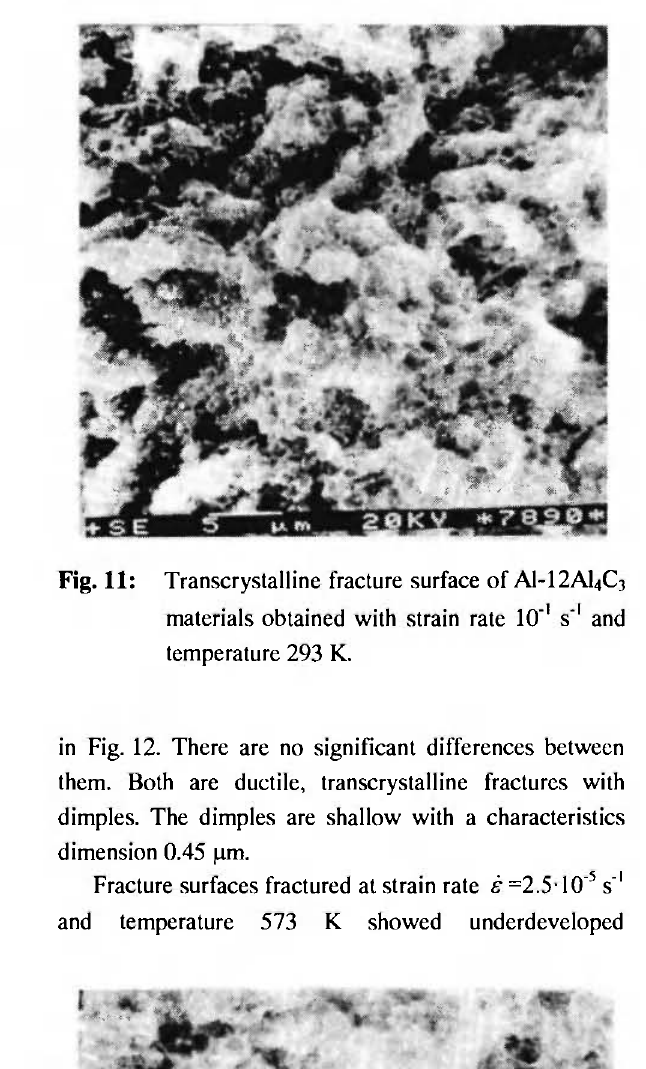
in Fig. 12. There are no significant differences between them. Both are ductile, transcrystalline fractures with dimples. The dimples are shallow with a characteristics dimension 0.45 μιη.